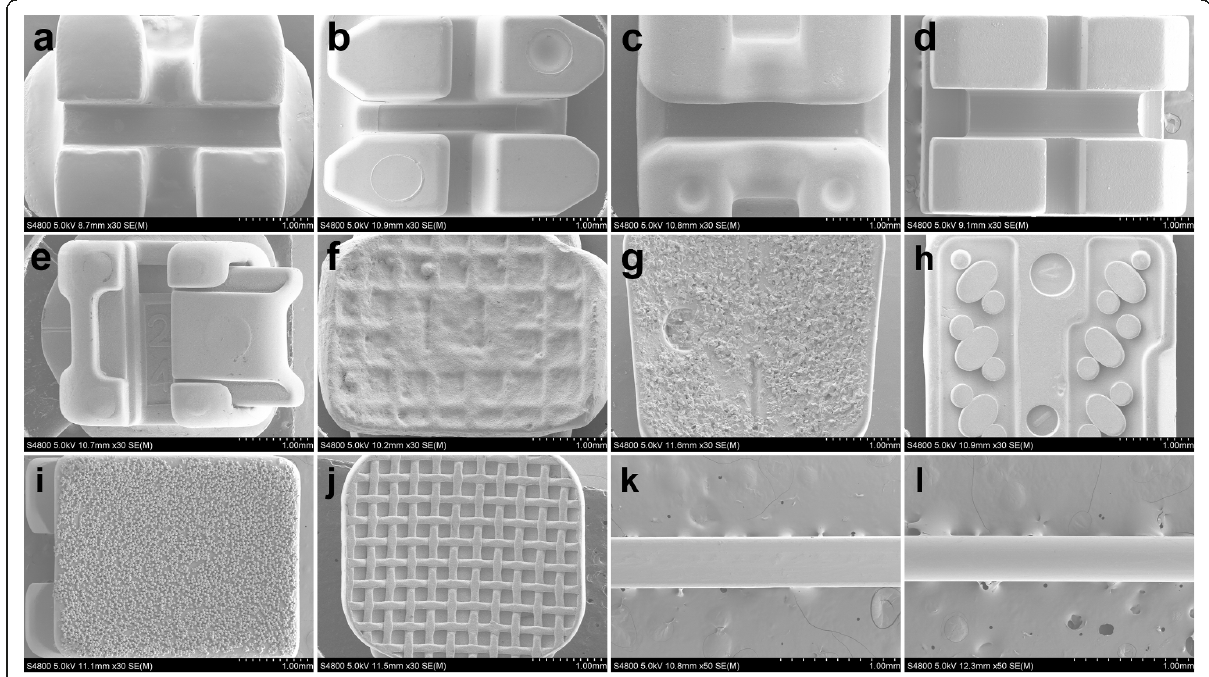
Fig. 4 SEM images of bracket bodies, at 30×: a CCB; b CA; c C7; d IC. e DQ. Bracket bases, at 30×: f CCB; g CA; h C7; i IC; j DQ. Stainless steel archwires, at 50×: k edgewise archwire; l round